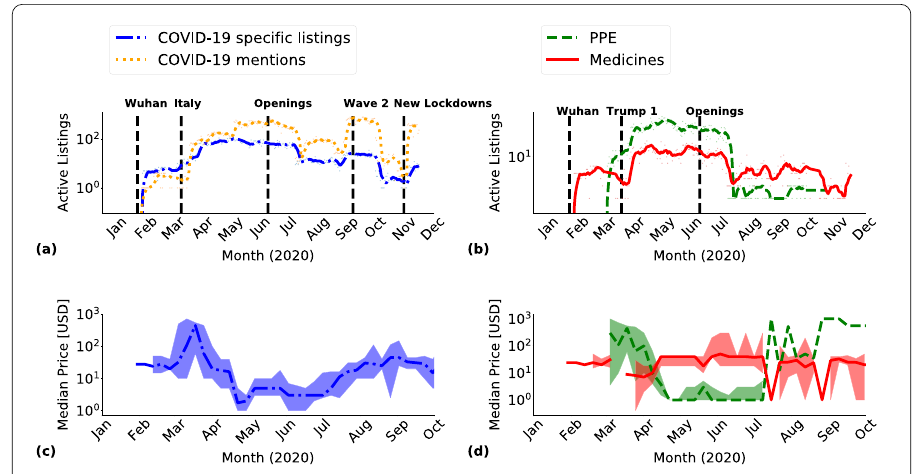
Figure 4 Longitudinal analysis of DWM activity. ( a ) Seven-days rolling average of active listings mentioning COVID-19 and COVID-19 specific listings. ( b ) Seven-days rolling average of the observed COVID-19 specific listings in the medicines and PPE categories. Black dashed vertical lines in panels ( a ) and ( b ) corresponded to significant COVID-19 world events, see Appendix C. ( c ) Seven-days median price with 95% confidence interval for COVID-19 specific listings. ( d ) Seven-days median price with 95% confidence interval for active COVID-19 specific listings in the PPE and medicines